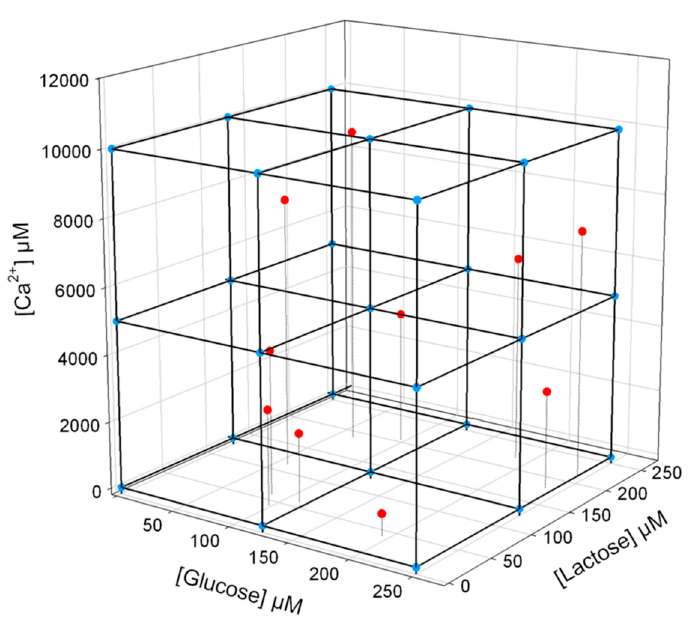
Figure 4. The artificial neural network (ANN) is based on two sets of standard solutions with different concentrations of lactose, glucose, and Ca 2+ analytes for training (factorial design, blue) and test (random, red), respectively. Reproduced with permission from [45].